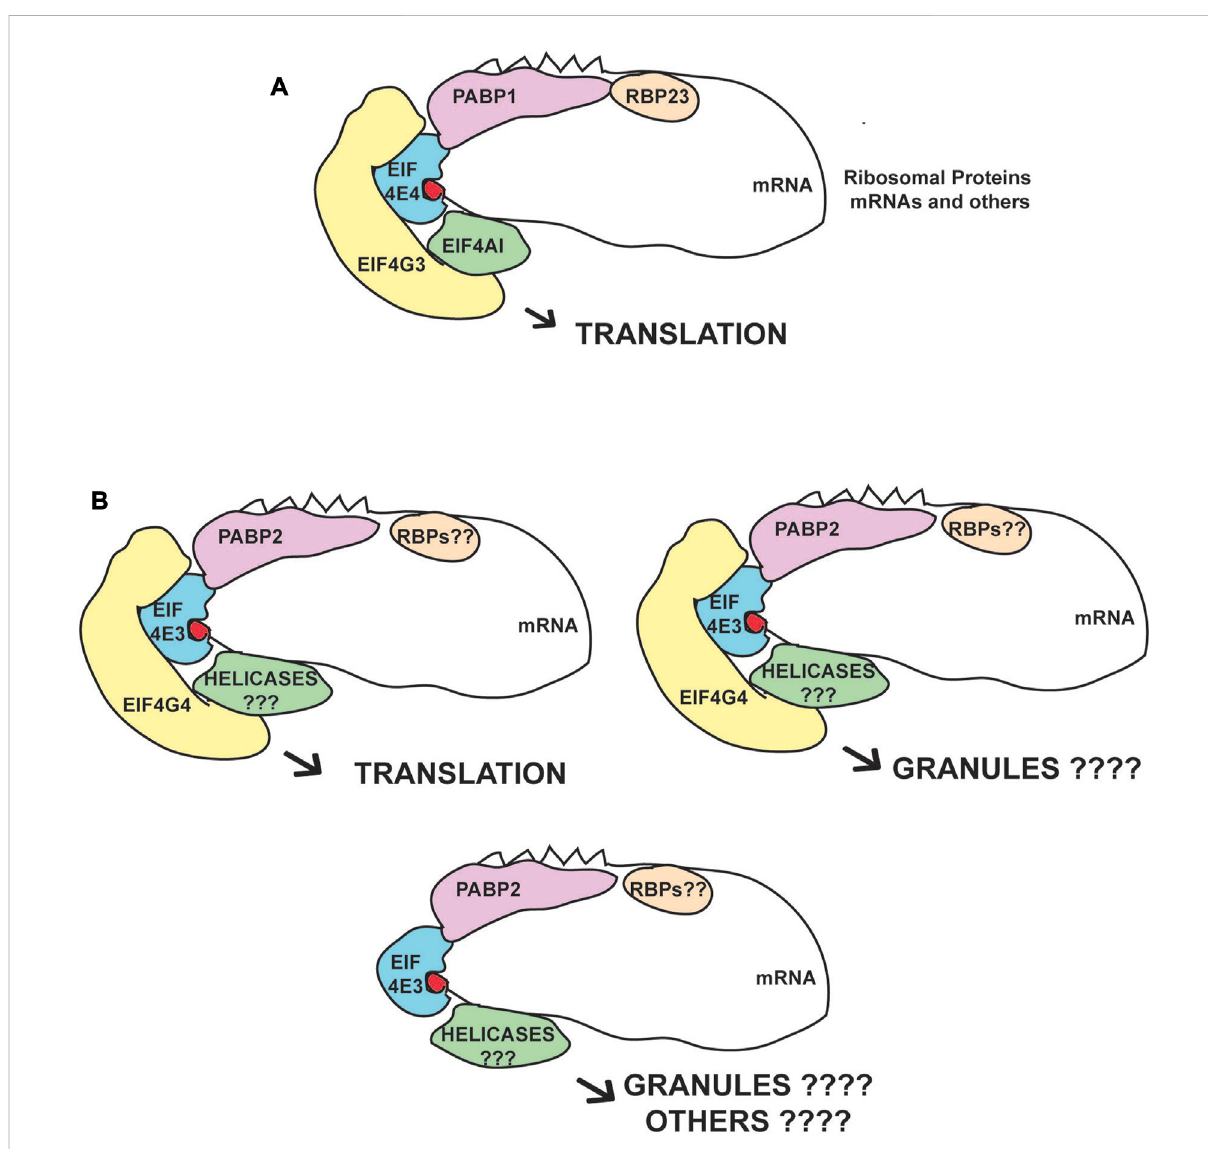
FIGURE 6 Proposed eIF4F-like complexesand variations based on the EIF4E3/EIF4G4 and EIF4E4/EIF4G3 subunits. (A) Consensus complex based on the immunoprecipitationdataandontheknowninteractionsbetweentheEIF4E4/EIF4G3subunitsanditscon fi rmedPABP1,EIF4AIandRBP23partners. This complex seems to act mainly on translation with the mRNAs encoding ribosomal proteins as their major targets. (B) Complexes based on the EIF4E3/EIF4G4 subunits and their association with PABP2. Roles in both translation and other processes associated with RNA granules are postulated. EIF4E3 may also function in the absence of EIF4G4, due to the large difference in abundance between the two proteins, but the pairing between EIF4G4 and EIF4E3 is likely essential for translation and viability. We propose that the different RNA helicases and RBPs that speci fi cally associate with these complexes modify their